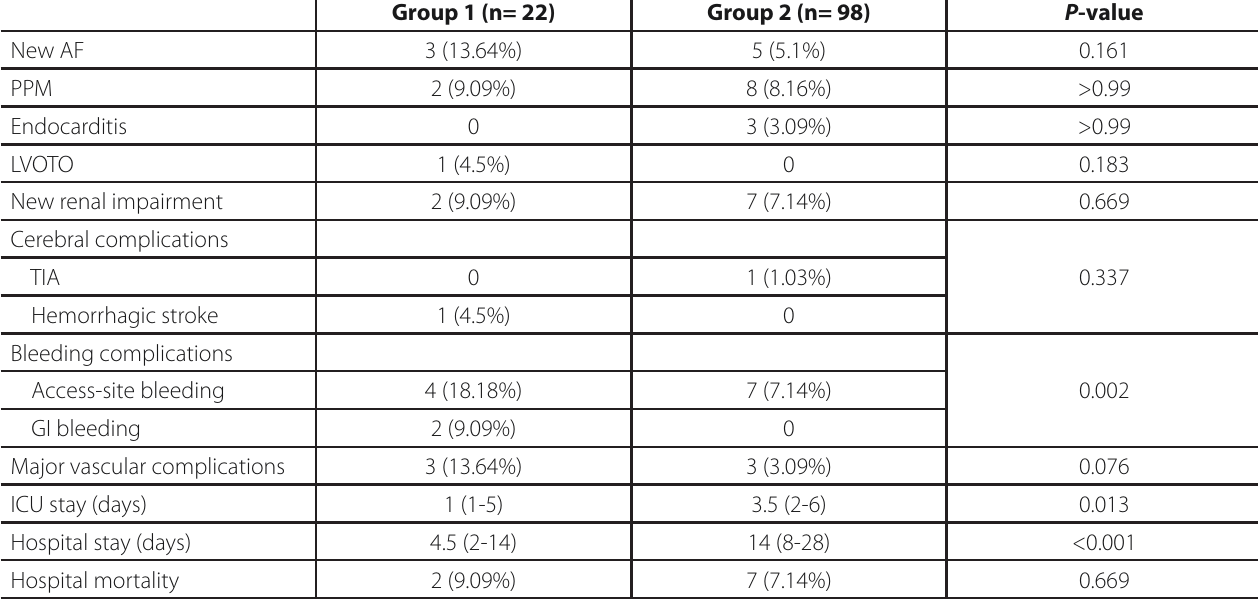
Table 2. Postoperative outcomes.